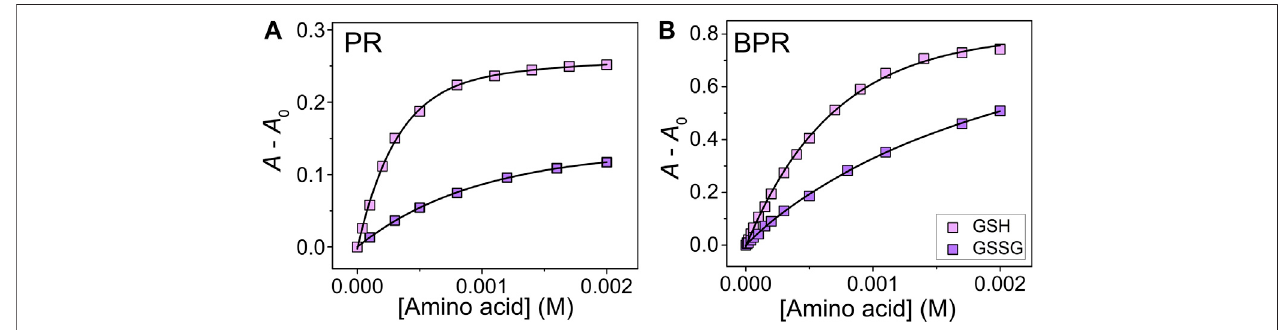
FIGURE 2 | UV-Vis titration isotherm of (A) PR – Zn 2+ and (B) BPR – Zn 2+ to GSH and GSSG (0 – 2.0 mM) at 25 ° C. The concentrations of dye and Zn 2+ were 40 μ